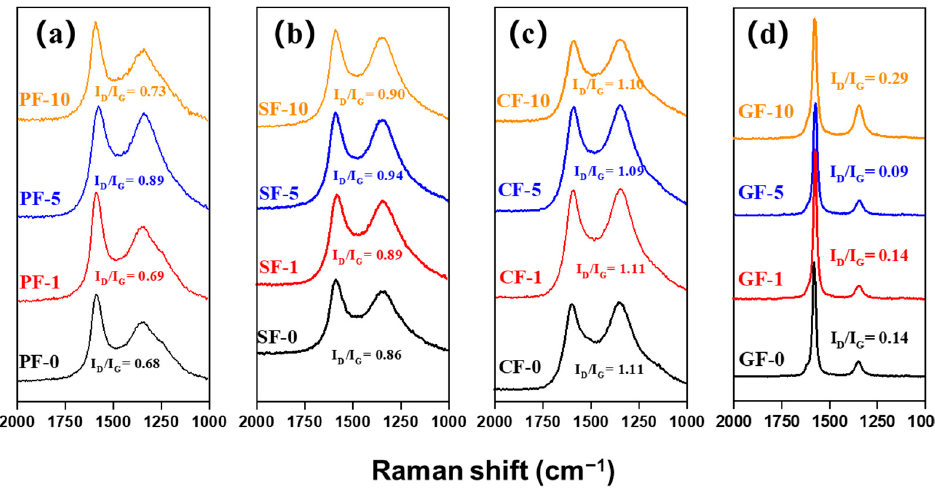
Figure 7. Raman spectrum of different PIM-derived ( a ) pitch fibers, ( b ) stabilized fibers, ( c ) carbonized fibers and ( d ) graphitized fibers.